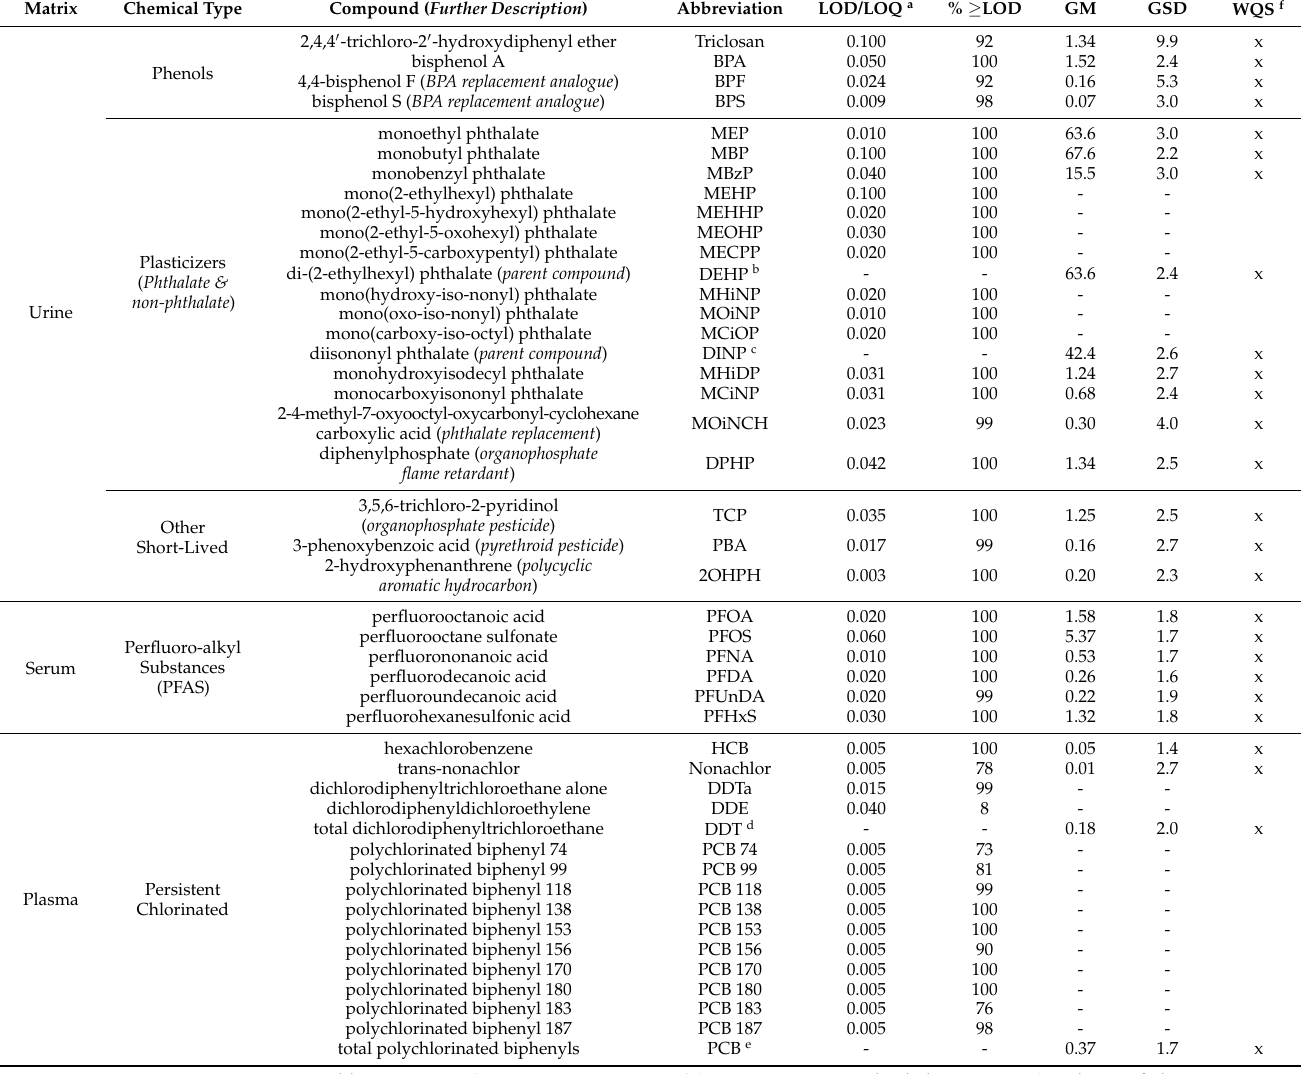
Table A1. EDCs measured in first-trimester maternal biological samples (ng/mL) (N =